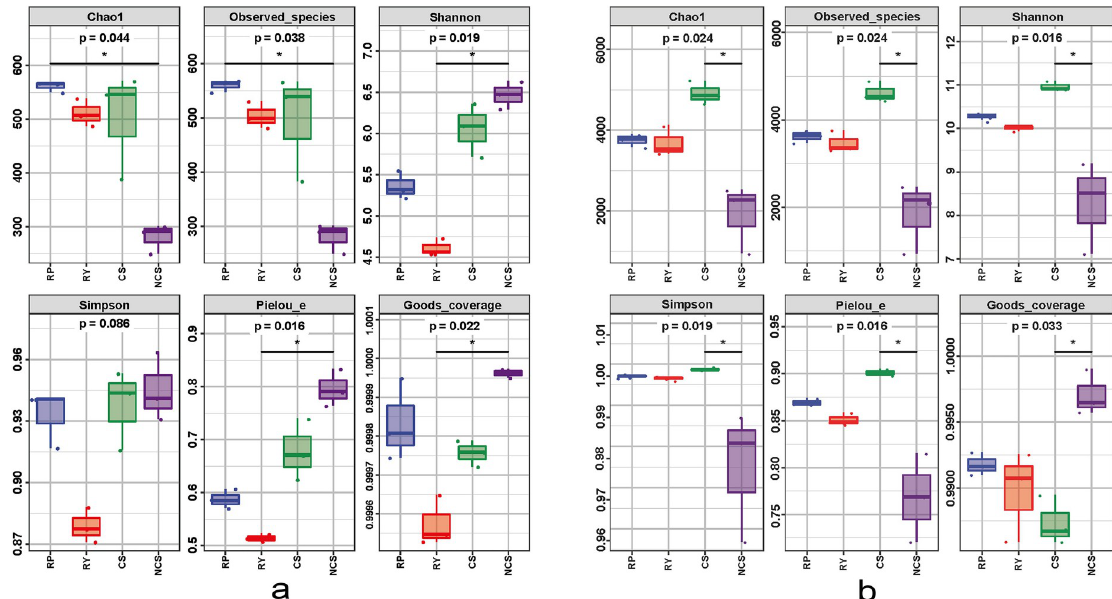
Fig 3. Alpha diversity analysis for fungi (a) and bacteria (b) in different soil and rhizosphere samples. The significance is expressed by the p value according to the Kruskal-Wallis test.